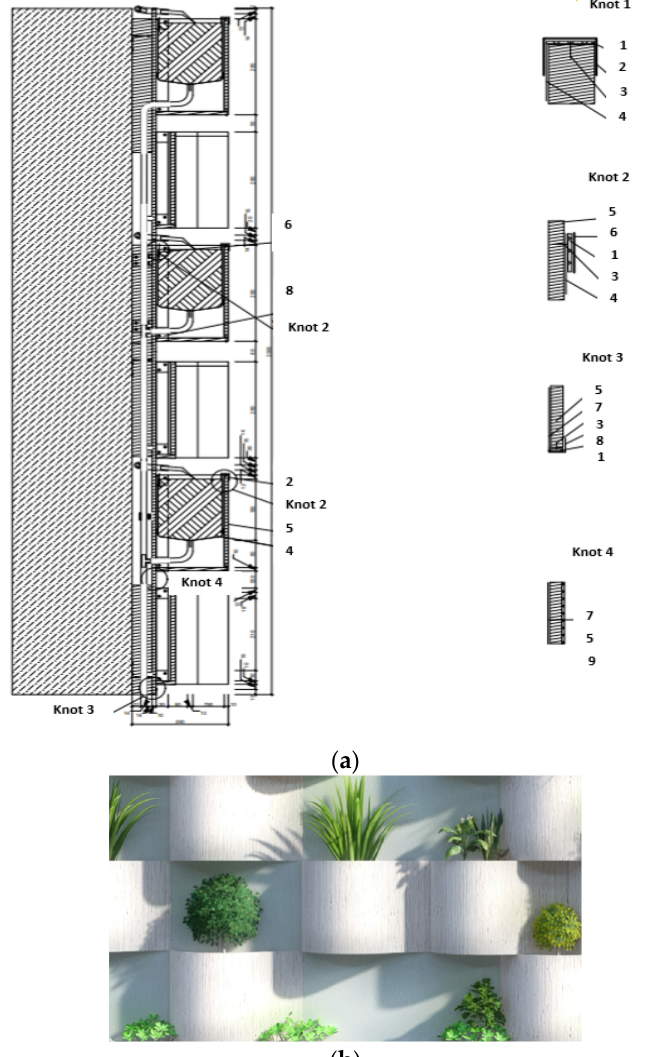
Figure 2. Vertical greening systems, designed and patented by the authors: ( a ) Section view of innovative modular green wall systems; 1—sealant, 2—profile, 3—constructive bracket, 4—geotextile bag, 5—wooden plate, 6—plastic strip, 7—vapor barrier, 8—plastic corner, 9—water-based paint; ( b ) 3D view.